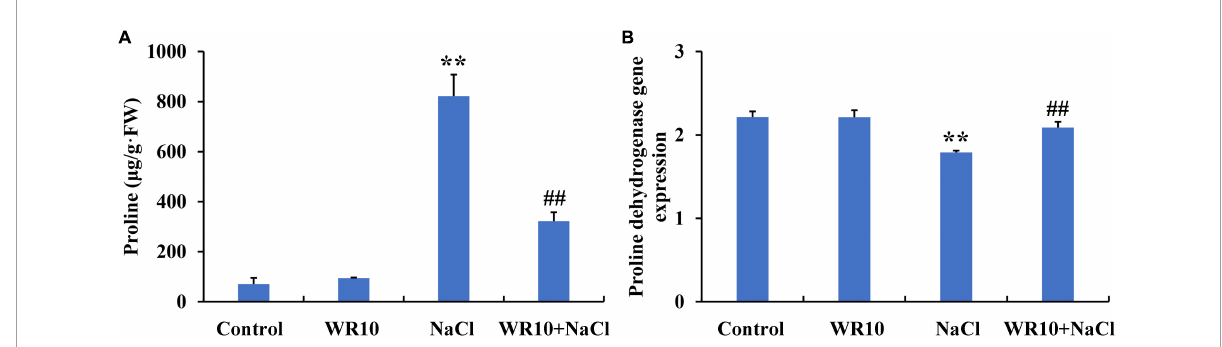
FIGURE7 Bacillus altitudinis WR10 decreases the proline content (A) in the shoots and increases the proline dehydrogenase gene expression (B) in the roots of wheat seedlings under salt stress. Control, without NaCl and WR10; WR10, with WR10 and without NaCl; NaCl, with NaCl and without WR10; WR10 + NaCl, with NaCl and WR10. Data are expressed as the means ± SD ( n = 6). ** p < 0.01 (vs. control); ## p < 0.01 (vs.